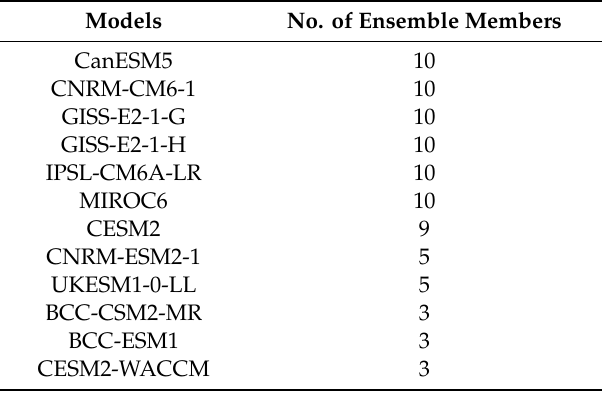
Table 1. The coupled models from CMIP6 historical simulations. Models No. of Ensemble